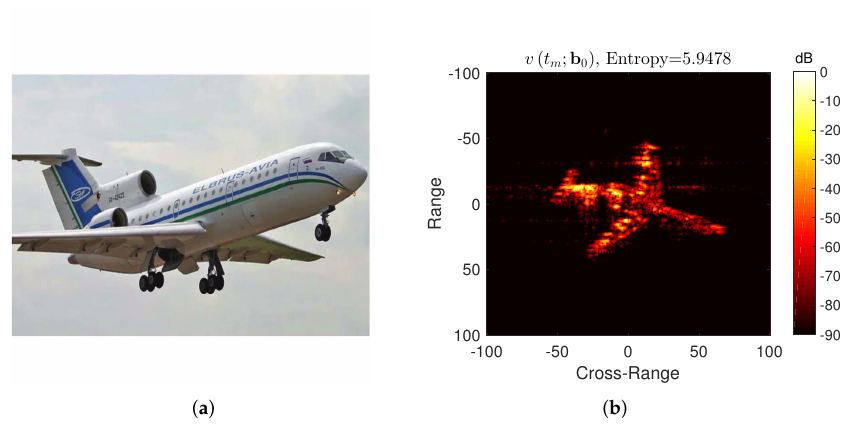
Figure 13. ( a ) Yak-42 airplane and ( b ) its standard ISAR image.